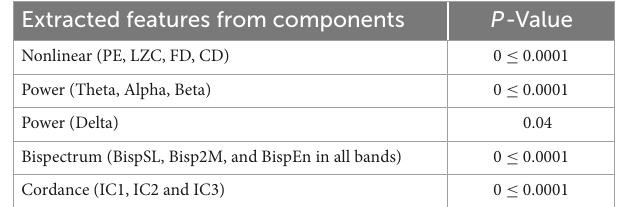
TABLE 2 Results of the ANOVA